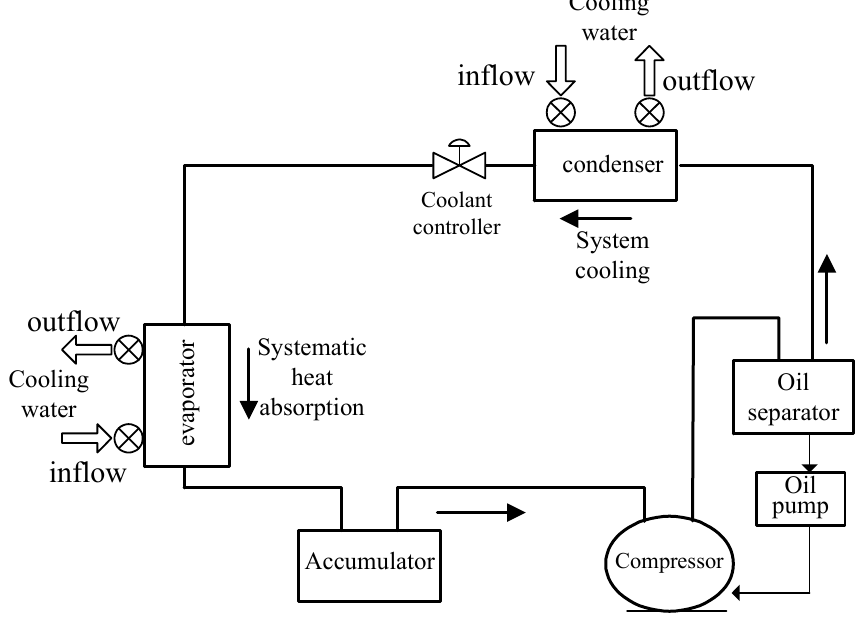
Figure 1. The refrigeration cycle system.